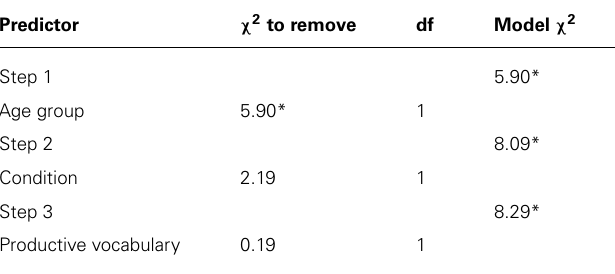
Table 4 | Logistic regression analysis predicting test performance from age group, condition, and productive vocabulary (extension trial).